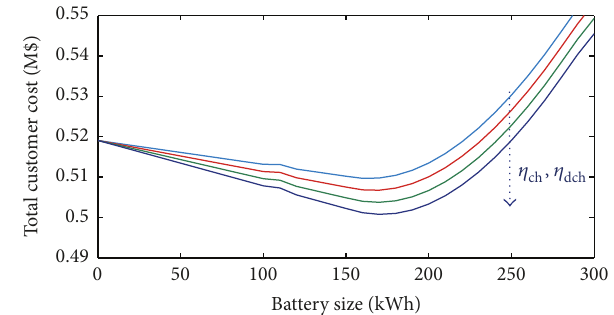
= 95 %, and Figure 5: Total customer cost with 𝛼 = 5 %, 𝛽 = 5 %, and 5% annual ch load variation and different values of BESS efficiency (residential